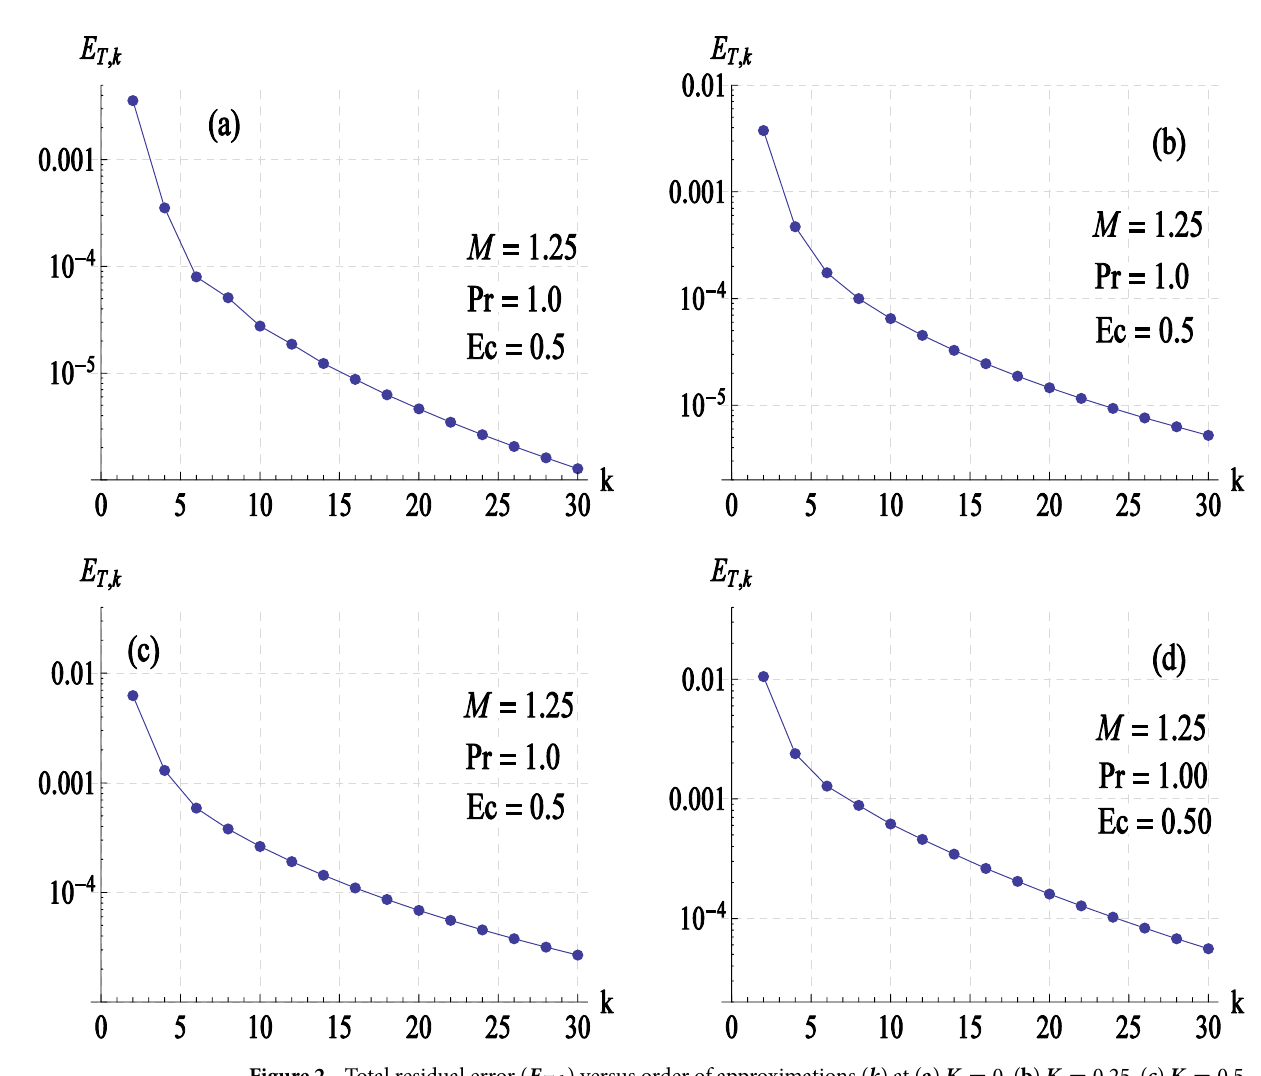
Figure 2. Total residual error ( E T , k ) versus order of approximations ( k ) at ( a ) K = 0 , ( b ) K = 0.25 , ( c ) K = 0.5 and ( d ) K = 0.8